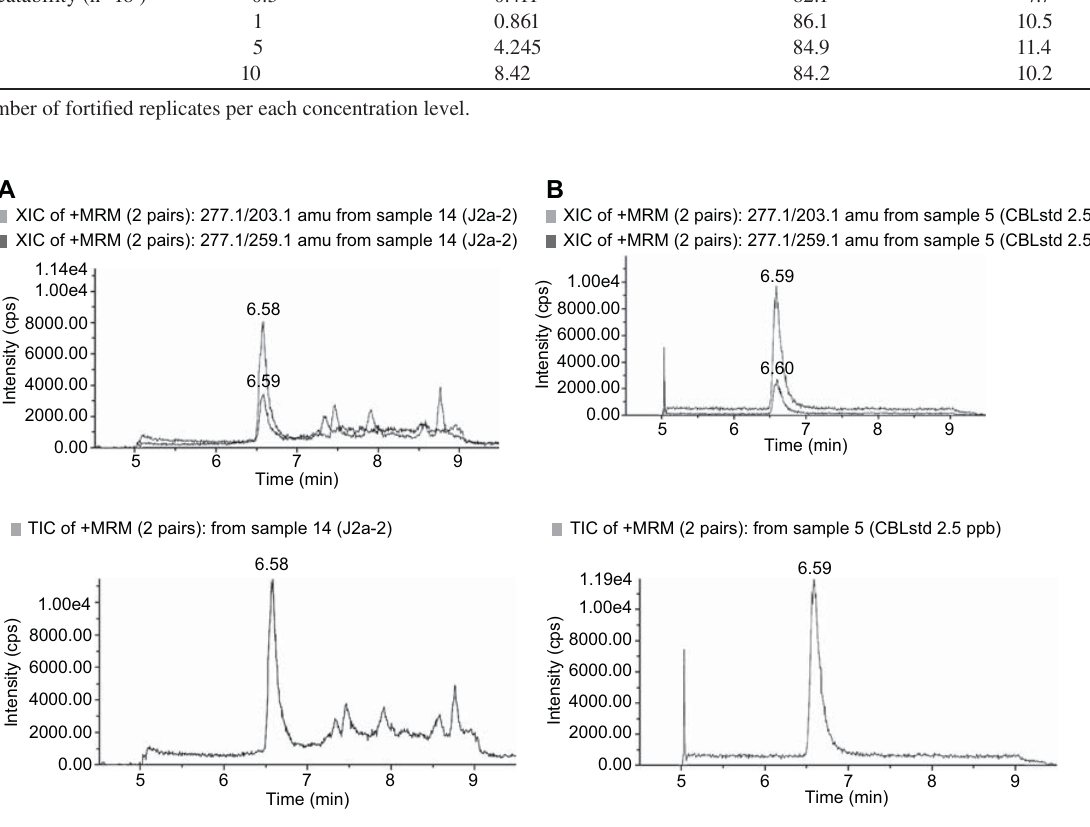
Figure 1 The confi rmatory chromatographic signals of clenbuterol obtained from LC-ESI/MS/MS analysis of the liver from treated pig (A) and clenbuterol standard (B), shown as separate overlain MRM functions (fi rst row) and sum signal (second row). report (Doerge et al. 1996 ). The analytical procedures using LC-ESI/MS/MS as a quantifi cation and confi rmation method ples